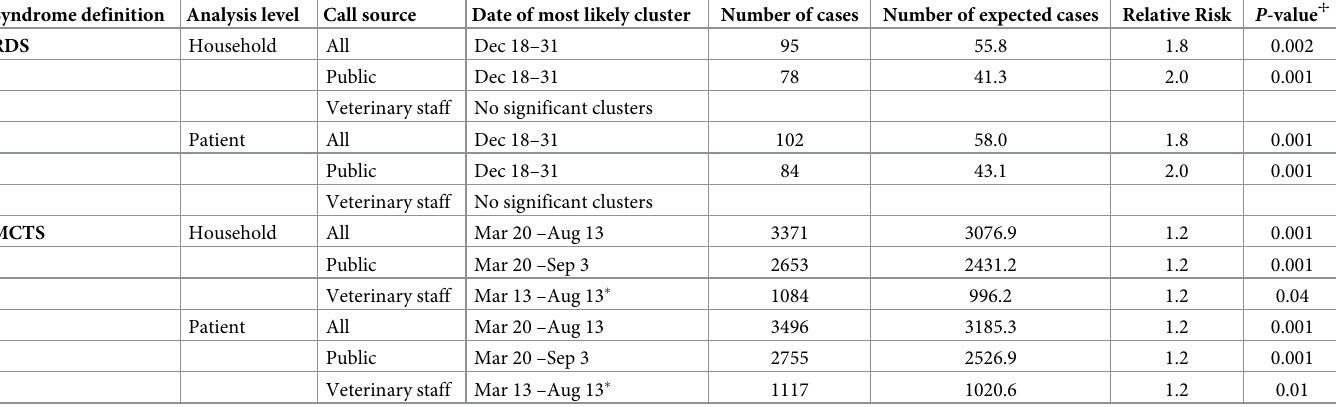
Table 5. Results of unadjusted retrospective temporal scan statistics using a Poisson model examining renal dysfunction syndrome (RDS) and melamine-cyanuric acid toxicity syndrome (MCTS) calls involving dogs and cats to the APCC 1 (January 1 –December 31, 2007). Syndrome definition Analysis level Call source